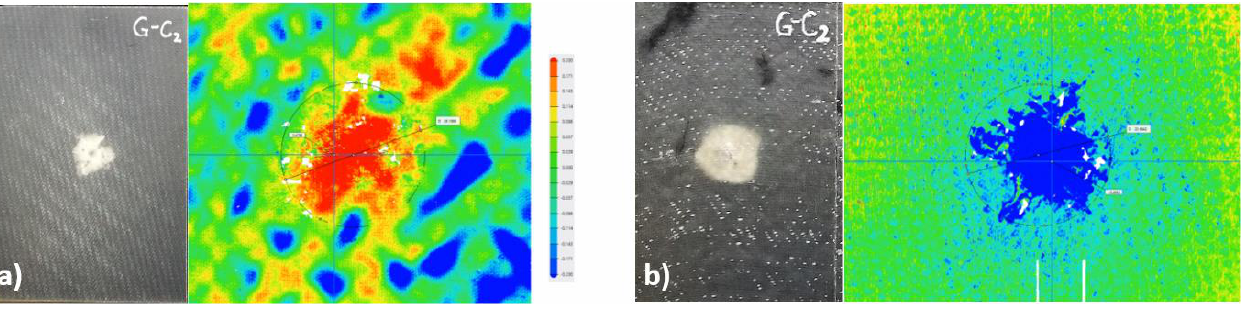
Figure 8. ( a ) Front, ( b ) back sides laser scan measurements of sample G-C2 damaged area.